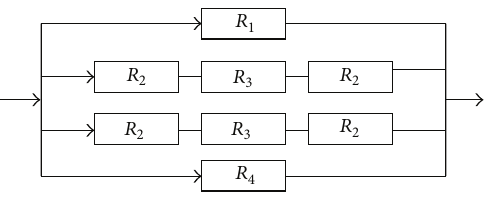
Figure 4: Thermal network